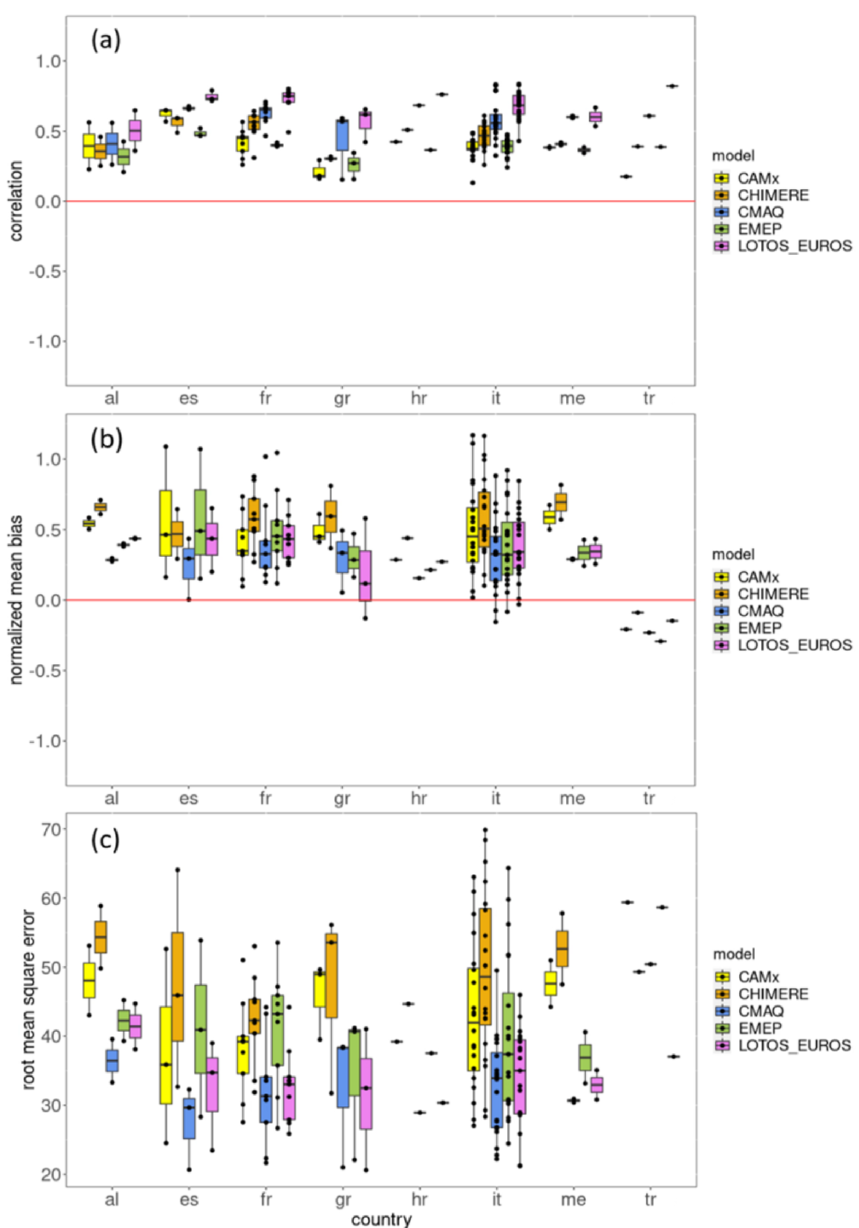
Figure 6. (a) Correlation, (b) NMB and (c) RMSE for annual mean O 3 concentration. Dots display values at measurement stations for the respective countries (al: Albania; es: Spain; fr: France; gr: Greece; hr: Croatia; it: Italy; me: Montenegro; tr: Turkey). Boxplots are for the models with the boxes displaying the interquantile range (IQR) between the 25th (Q1) and 75th (Q3) percentile, the black line displays the median (Q2), and whiskers are calculated as Q1 − 1 . 5 × IQR (minimum) and Q3 + 1 . 5 × IQR